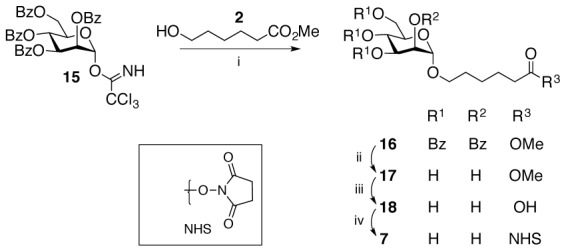
Alternate synthesis of mannose-NHS (7) [28].